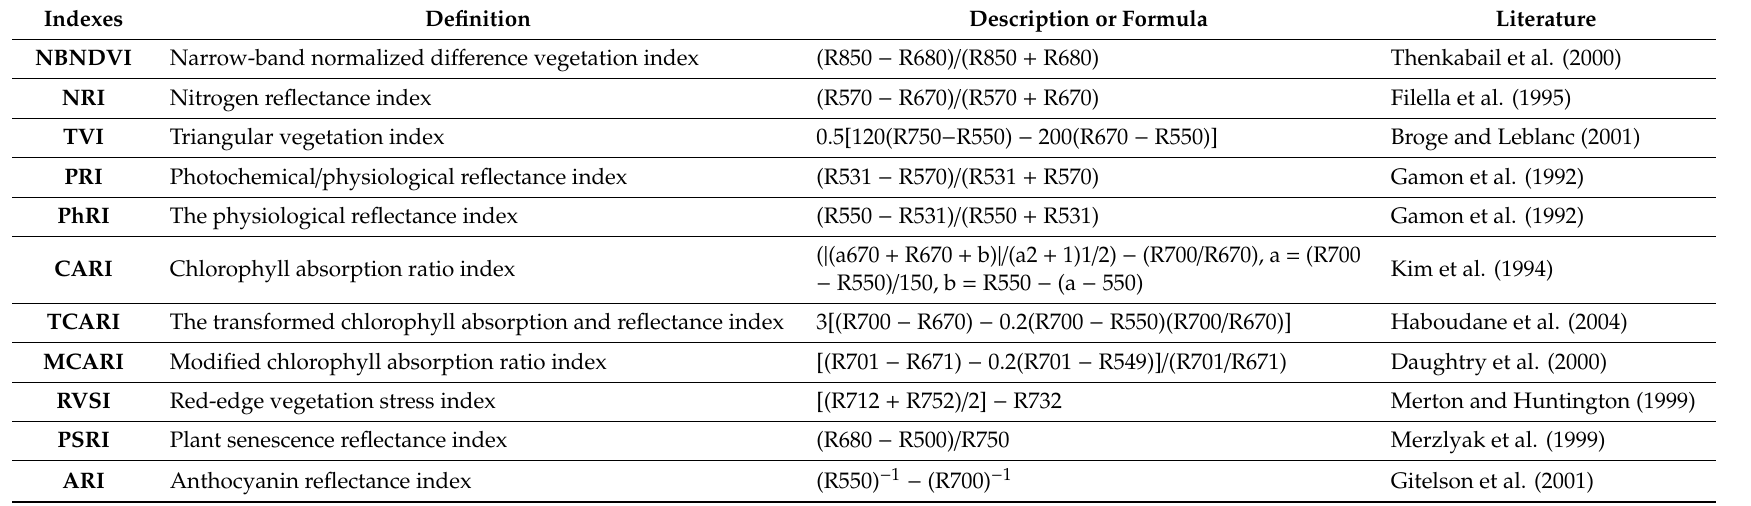
Table A2. Hyperspectral vegetation indices for plant disease